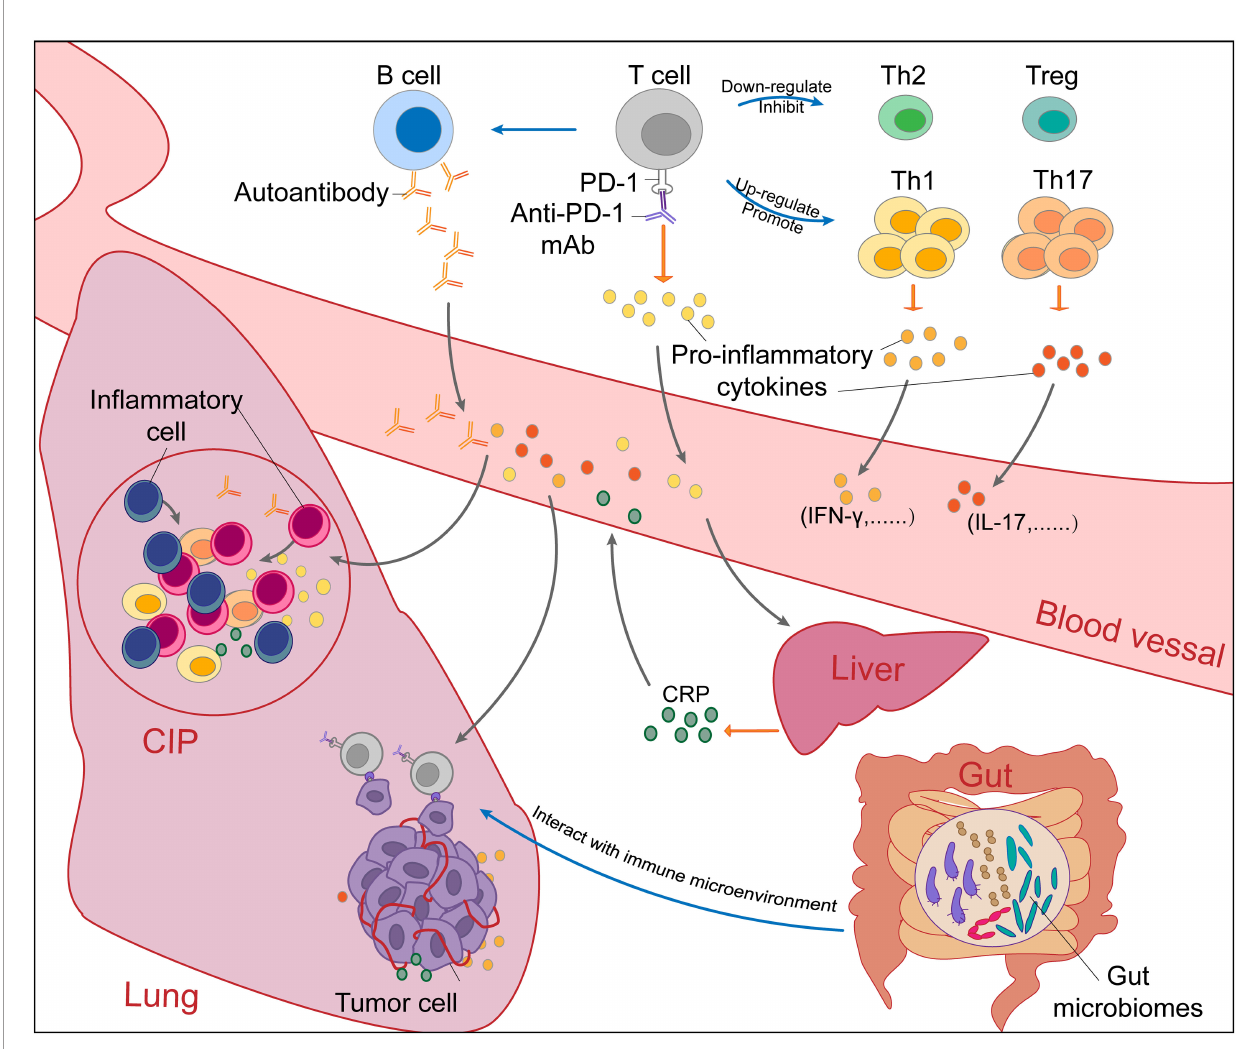
FIGURE 2 | The potential mechanisms of checkpoint inhibitor pneumonitis (CIP) in NSCLC patients receiving PD-1/PD-L1 inhibitor monotherapy. The occurrence of checkpoint inhibitor pneumonitis (CIP) in NSCLC is the result of a combination of many factors. Blockade of the PD-1-PD-L1 pathway by PD-1/PD-L1 mAbs (PD-1 mAb in the fi gure, for example) will upregulate and promote Th1 and Th17 cells and downregulate and inhibit Th2 cells and Tregs. Without immunosuppression of Th2 cells and Tregs, excessive immune responses and cytokine secretion of Th1 and Th17 cells will cause autoimmune damage in normal tissues such as the lung. In addition, autoantibodies increased after PD-1/PD-L1 blockade can also cause normal tissue lesions. Proin fl ammatory cytokines secreted by activated T cells promote the in fi ltration of in fl ammatory cells. Under the stimulation of IL-6, CRP produced by the liver will promote in fl ammation and strengthen autoimmunity. Through the “ gut-lung axis ” , gut microbiomes can regulate the immune microenvironment in the lung. Overall, the immune dysregulation caused by PD-1/PD-L1 blockade leads to the occurrence and development of CIP. NSCLC, non-small cell cancer; CIP, checkpoint inhibitor pneumonitis; PD-1, programmed cell death protein 1; PD-L1, programmed cell death protein ligand-1; mAbs, monoclonal antibody; Th, helper T cell; IL, Interleukin; CRP, C-reactive